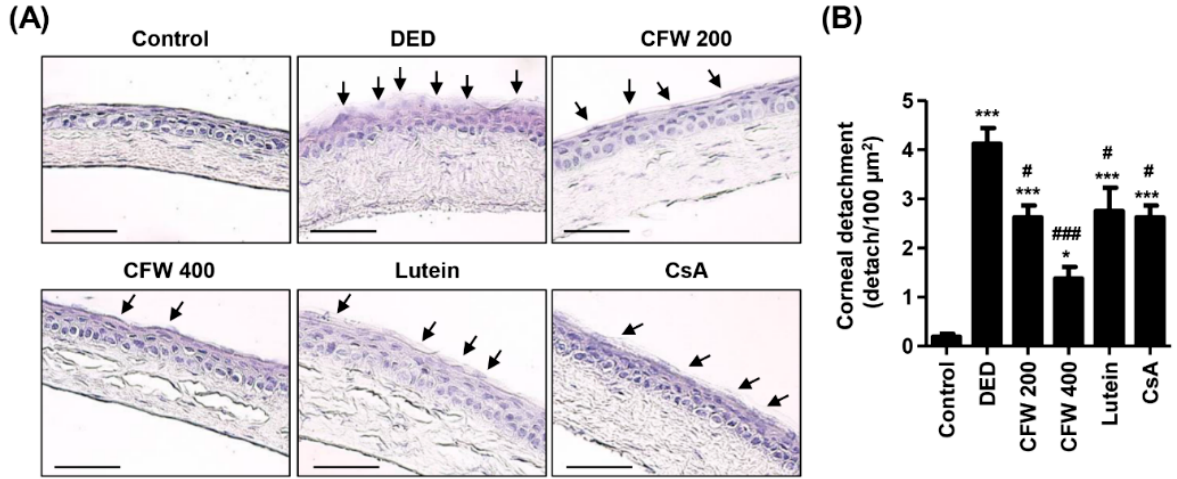
Figure 2. Effect of oral supplements of CFW on the detachment of corneal epithelium in PM 2.5 -induced DED rats. ( A ) Representative images of H&E-stained images of corneal sections ( n = 4). Black arrows indicate the detached and swollen epithelium. Scale bar, 50 µ m. ( B ) The numbers of the detached corneal epithelium of 100 µ m 2 in five different sections were counted. The data are expressed as the means ± standard deviation ( n = 10). * p < 0.05 and *** p < 0.001 compared to the control group. # p < 0.05 and ### p < 0.001 compared to the PM 2.5 -induced DED group.